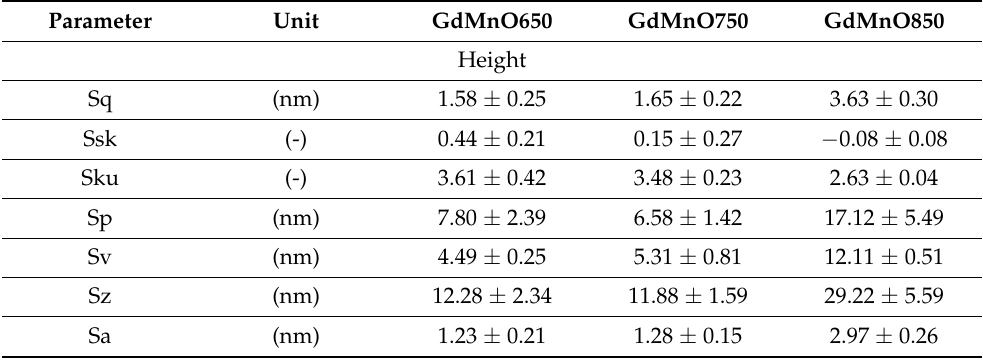
Table 2. Height surface parameters of GdMnO 3 thin films, according to ISO